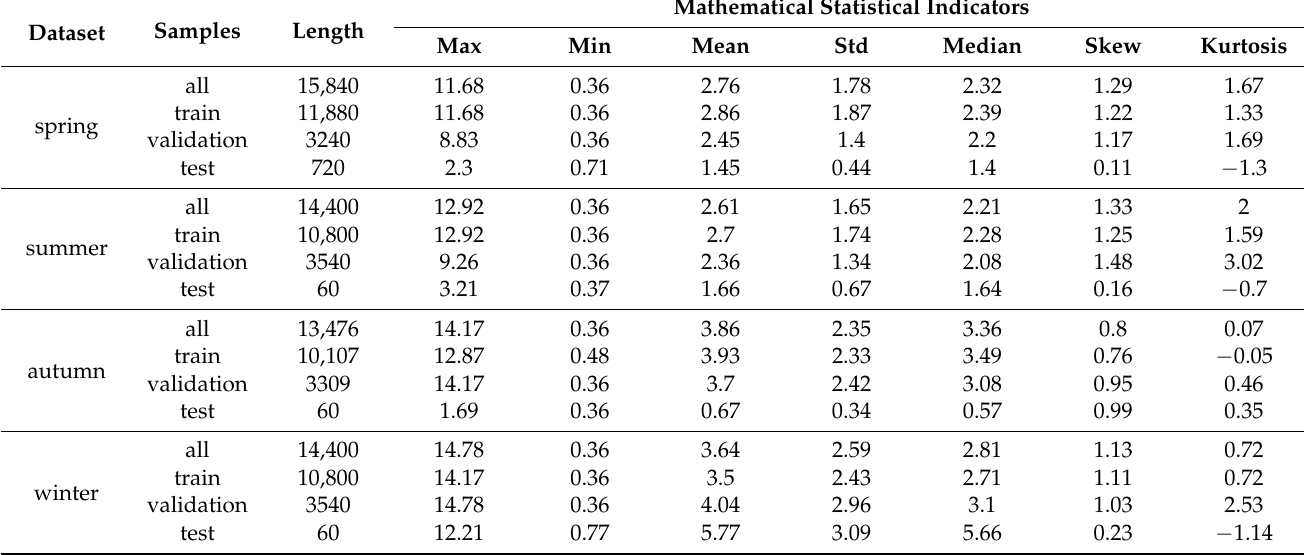
Table 2. Mathematical statistics of the four types of data.